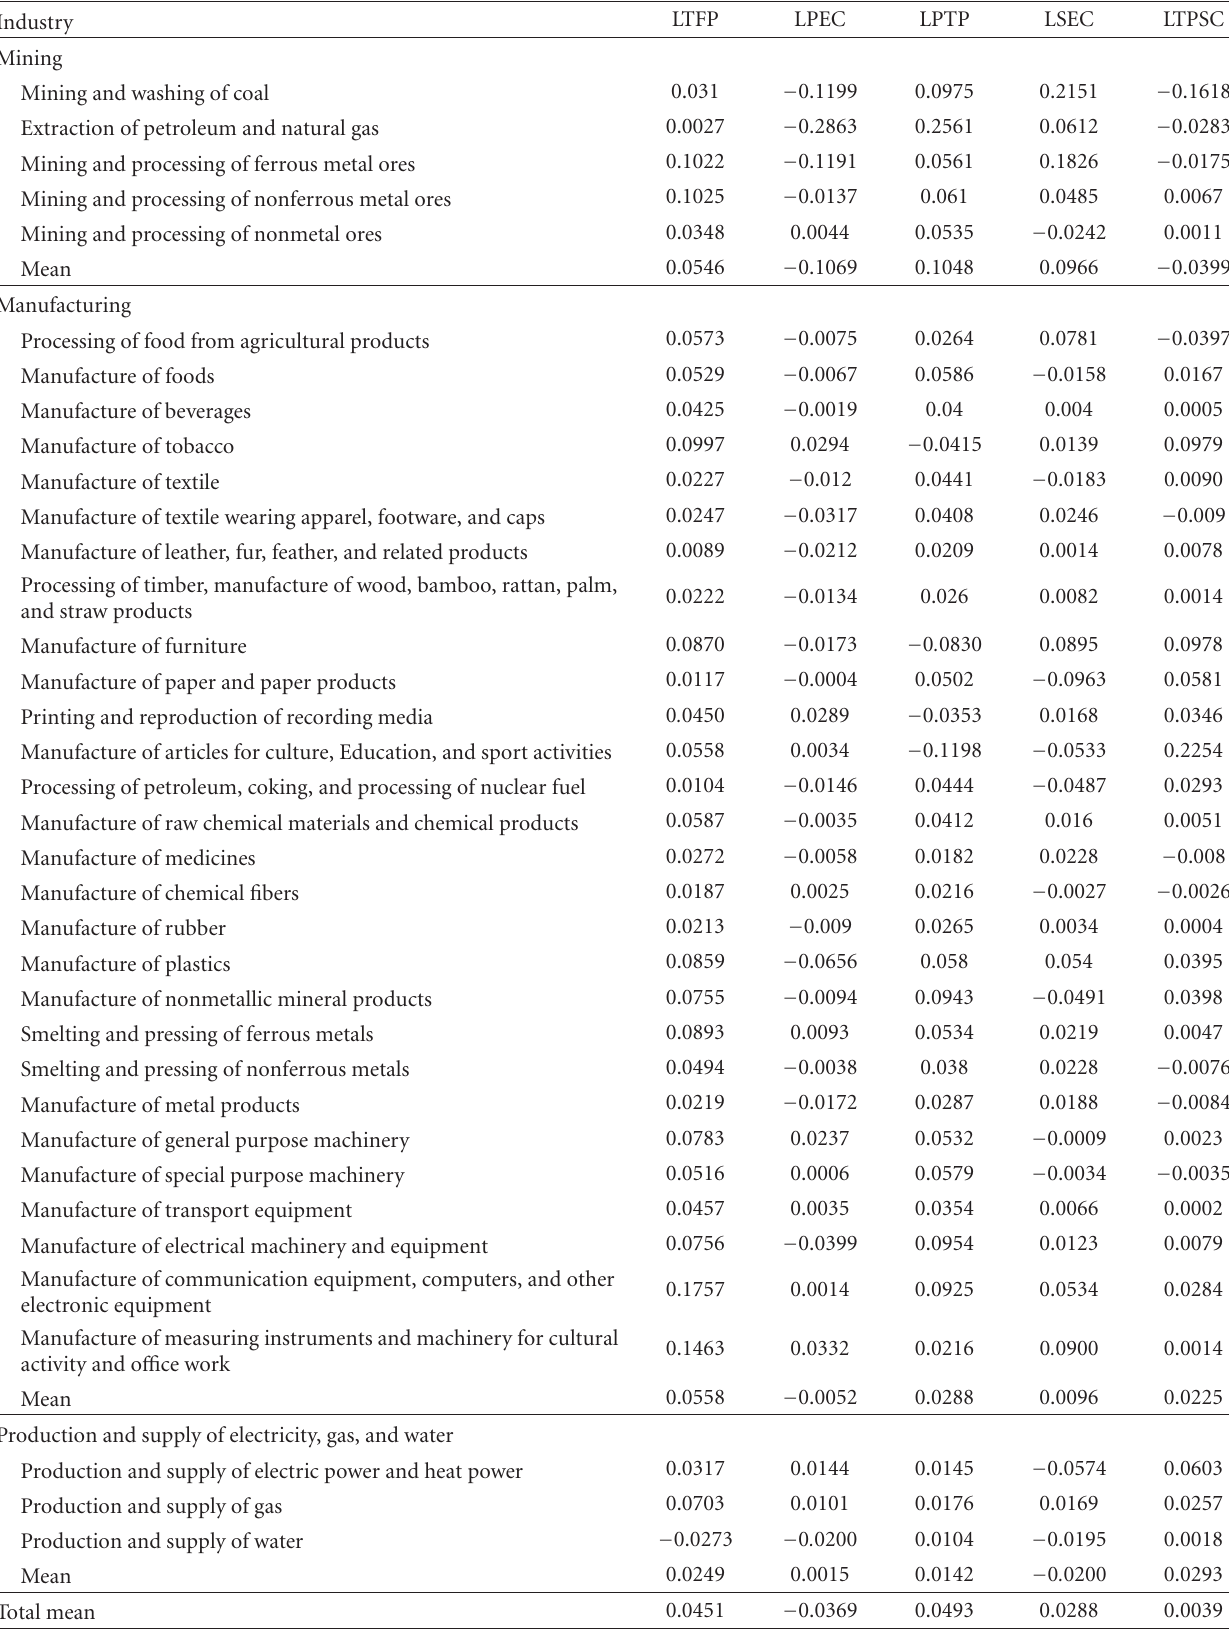
Table 2: Environmental TFP and its components of China’s